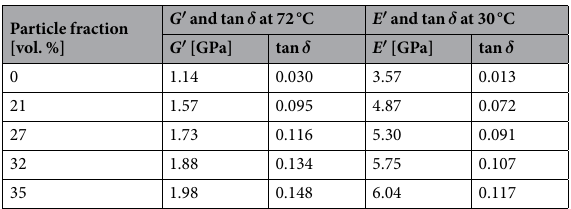
Table 2. Calculated peak viscoelastic moduli for composites with the various particle fractions manufactured in this study. First at 72 °C, using the directly measured coating viscoelastic data and second, by shifting the coating data to give a peak in tan δ at 30